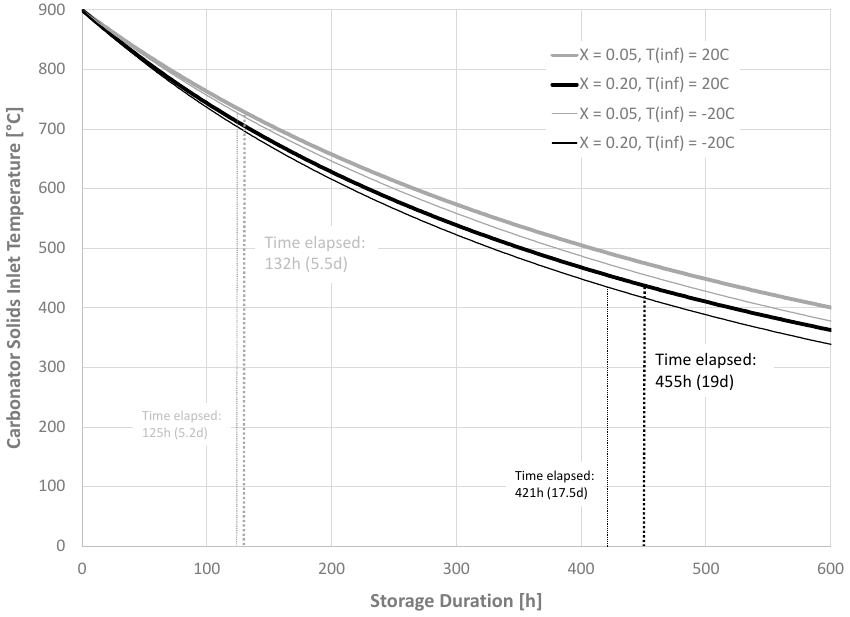
Figure 10. Carbonator solids inlet temperature as a function of storage duration for Configuration 1.